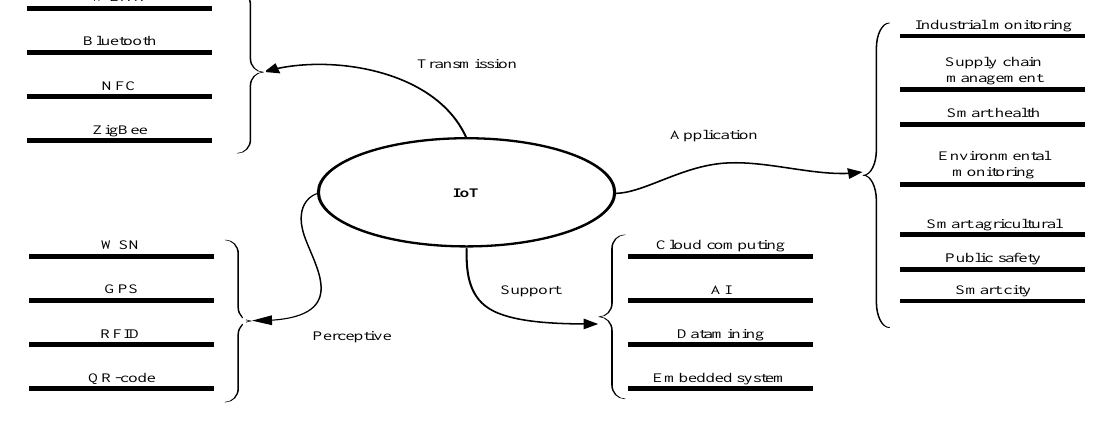
Figure 1. Essential IoT technologies.